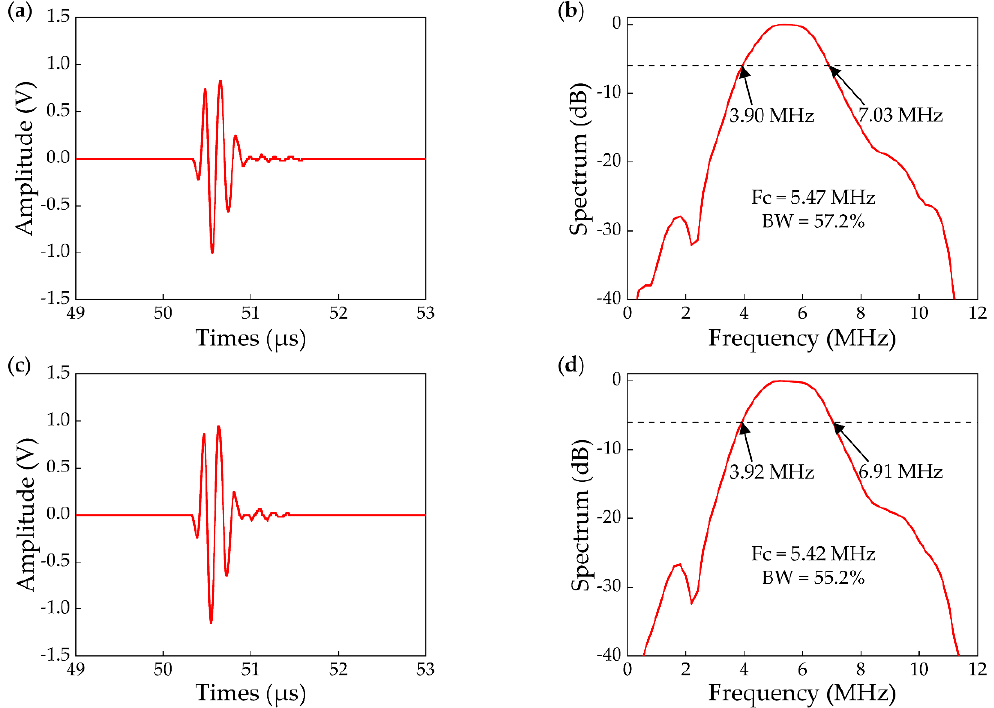
Figure 3. Transmit characteristic of the ring-array transducer. ( a , b ) Measured waveform and spectrum diagram of the 25-th element of the ring-array transducer; ( c , d ) Measured waveform and spectrum diagram of the 96-th element of the ring-array